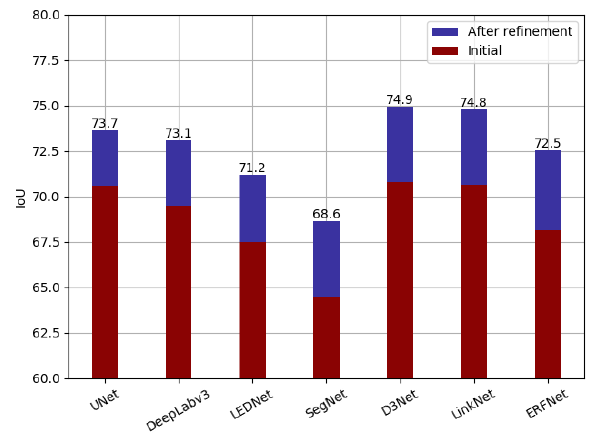
Figure 7. Study of the impact of the architecture choice on the Potsdam validation set sorted per IoU gain.